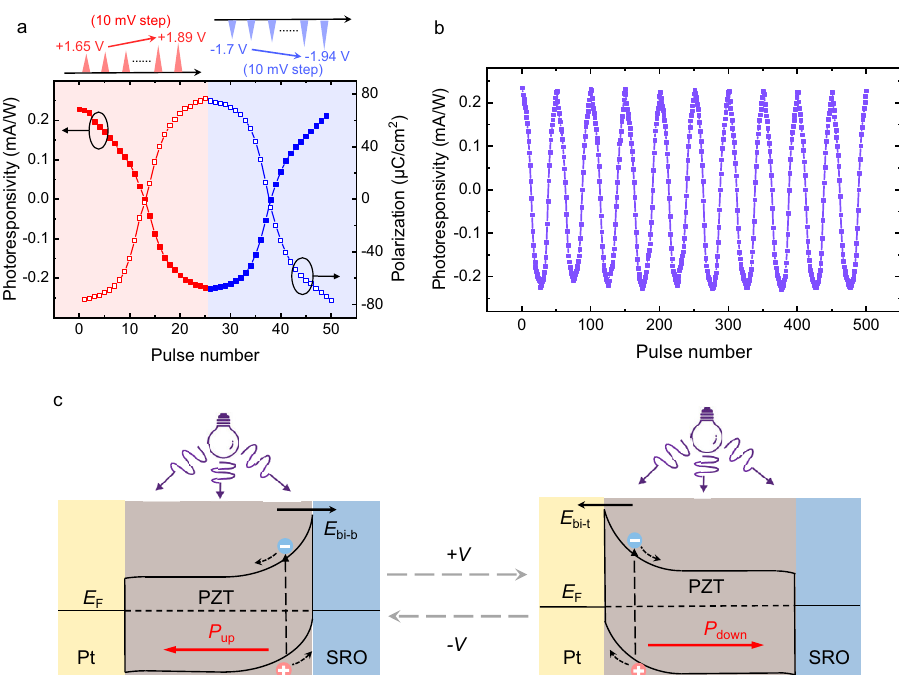
Fig. 3 Synaptic behavior and operation mechanism of FE-PS. a One-cycle LTD and LTP characteristics where the photoresponsivity represents the weight along with the evolution of polarization during the pulse application. Upper panel shows the schematics of the positive and negative pulses applied in succession, while the preset pulse applied at the very beginning is not shown. b Multi-cycle LTD and LTP characteristics. c Schematic energy band diagrams of the FE-PS in the complete P up (left panel) and P down (right panel) states. The polarization switching can tune the Schottky barrier heights and built-in fi elds at the two interfaces, thus modifying the magnitude and direction of the overall output